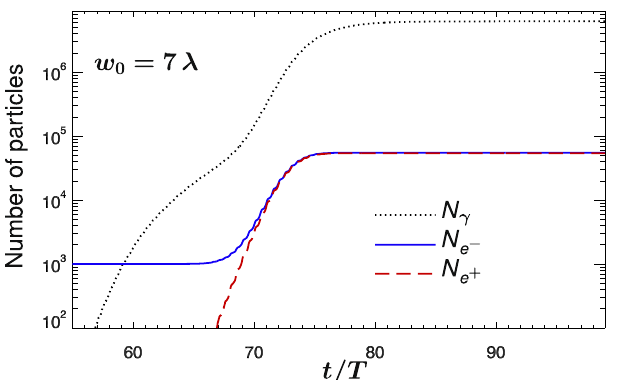
(solid blue line), e